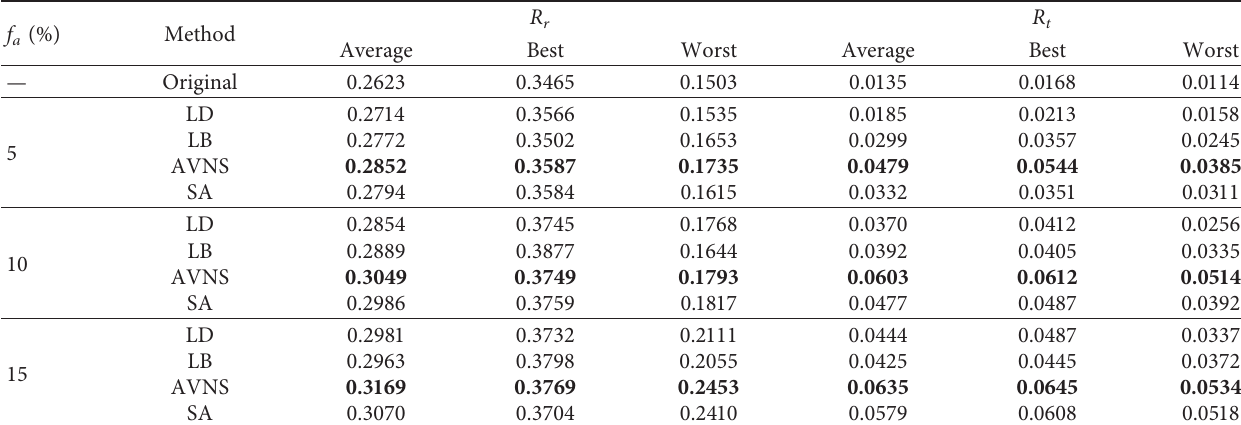
Table 2: Robustness comparison of chain 14 and reconfigured